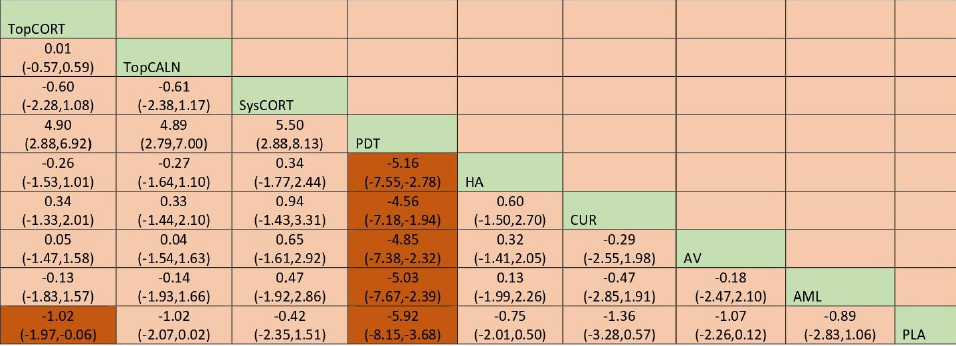
Figure 11. League table for clinical score. Abbreviations: AML, amlexanox paste; AV, aloe vera; CUR, curcumin gel; PDT, photodynamic therapy; PLA, placebo; PUR, purslane; SysCORT, systemic corticosteroid; TopCALN, topical calcineurin; TopCORT, topical corticosteroid; HA, hyaluronic acid. The green highlights indicate the interventions and the dark highlights indicate the significant results.